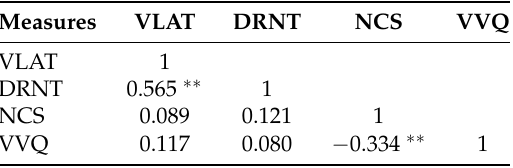
Table 2. Correlations Between Four Measurement Scores ( N =